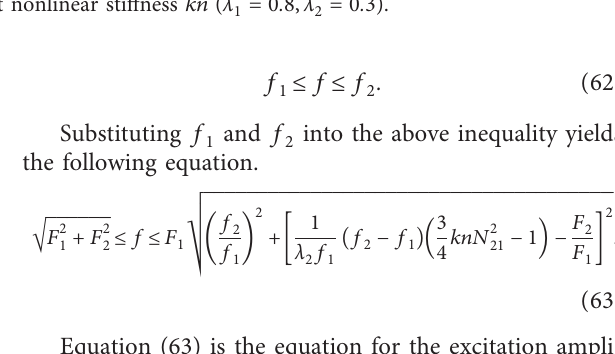
Figure 14: NES amplitude N